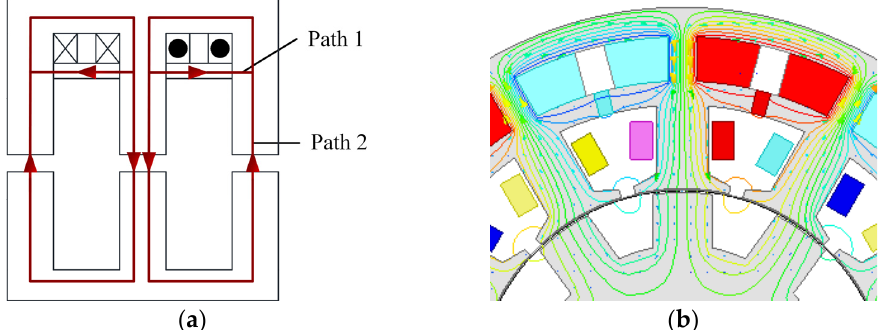
Figure 5. Magnetic flux paths of hybrid excitation when J f > J f 0 : ( a ) theoretical paths; ( b ) FEA paths.